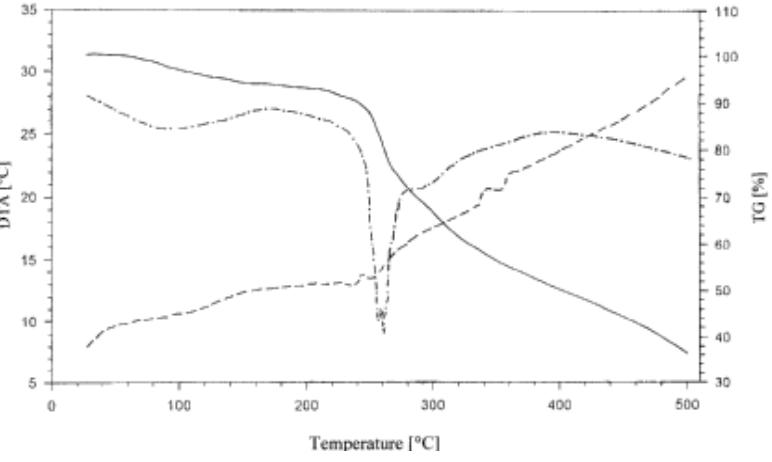
Figure 6. Thermogram (TG, DTG, DTA) of casein/GPCS 1:1 complex in the 25-500 o C range.